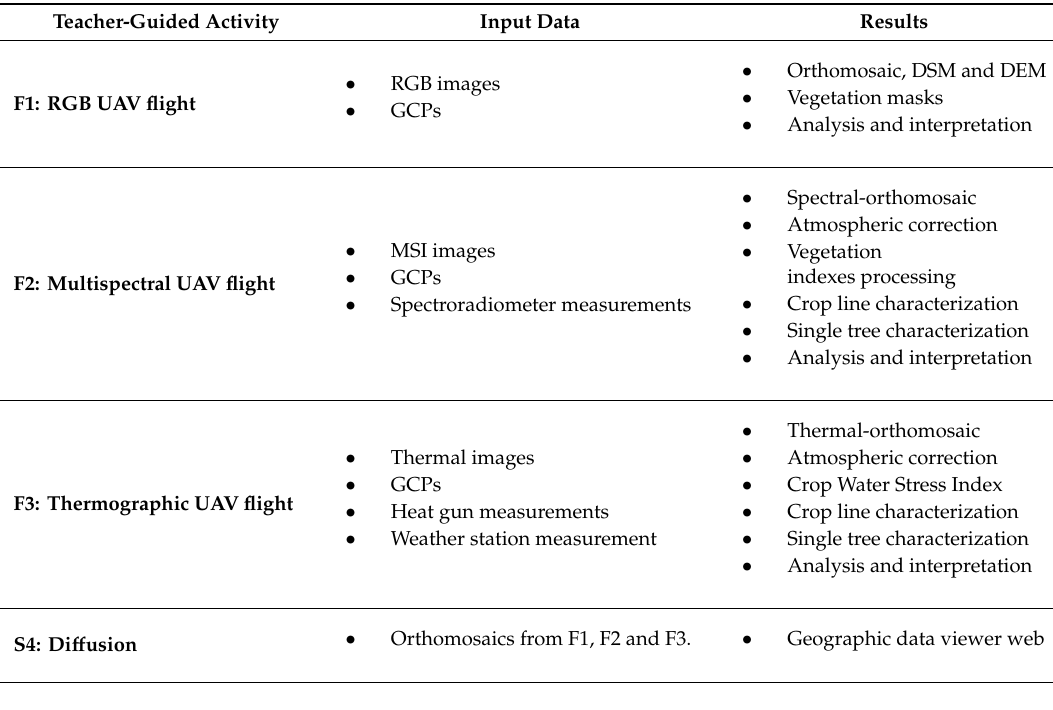
Table 4. Input data and results of each of the self-directed activities carried out by students linked to fieldwork and